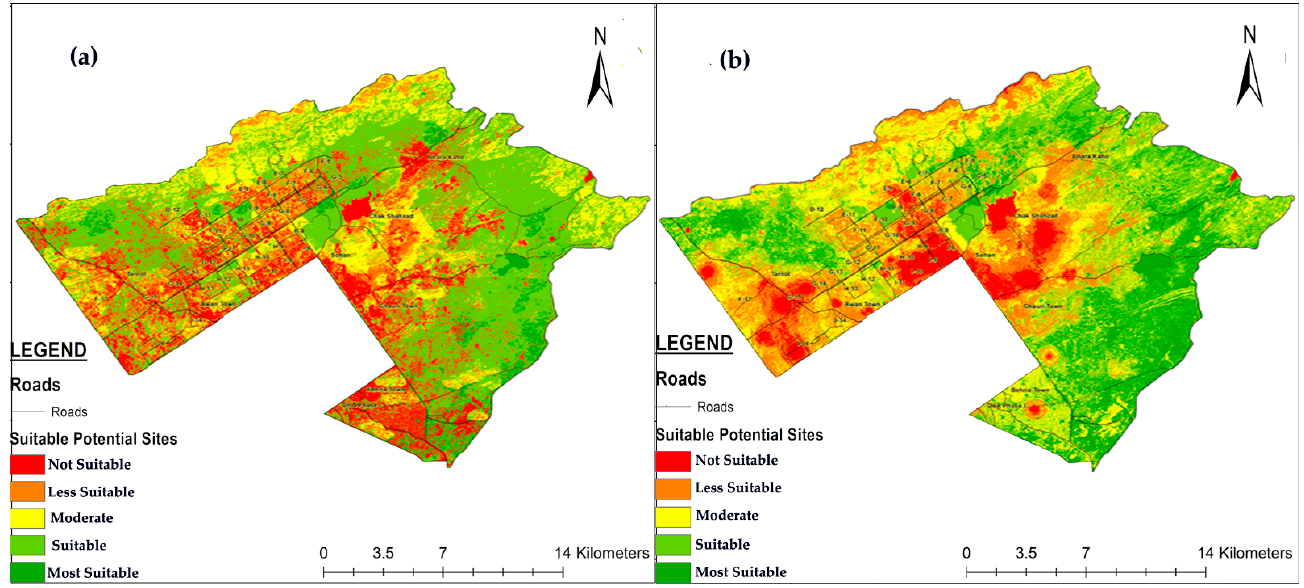
Figure 8. Suitability map obtained from AHP-WLC ( a ) and fuzzy logic ( b ).